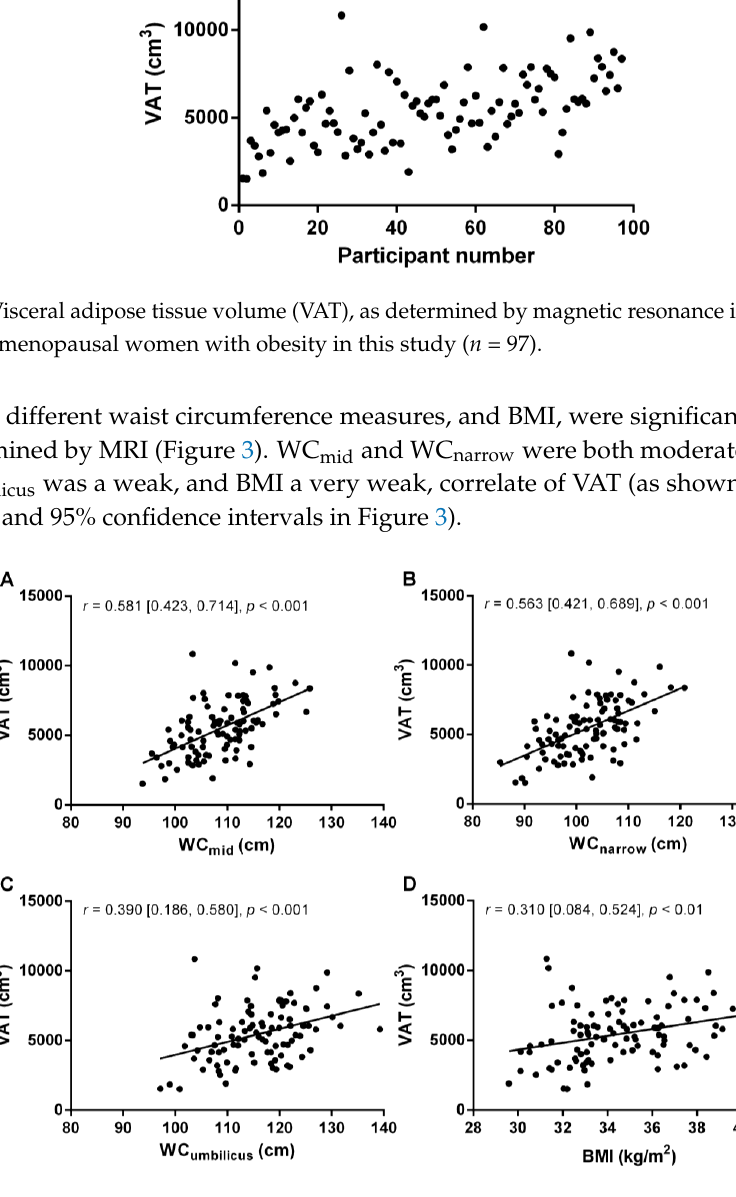
Figure 3. Visceral adipose tissue volume (VAT), measured by magnetic resonance imaging, versus waist circumference measured at the midpoint (WC mid , A ); narrowest point (WC narrow , B ) and umbilicus (WC umbilicus , C ); as well as body mass index (BMI, D ), in postmenopausal women with obesity ( n = 97). Data on each panel represent correlation coefficients ( r ) as well as their 95% confidence intervals [lower limit, upper limit], and corresponding p values.